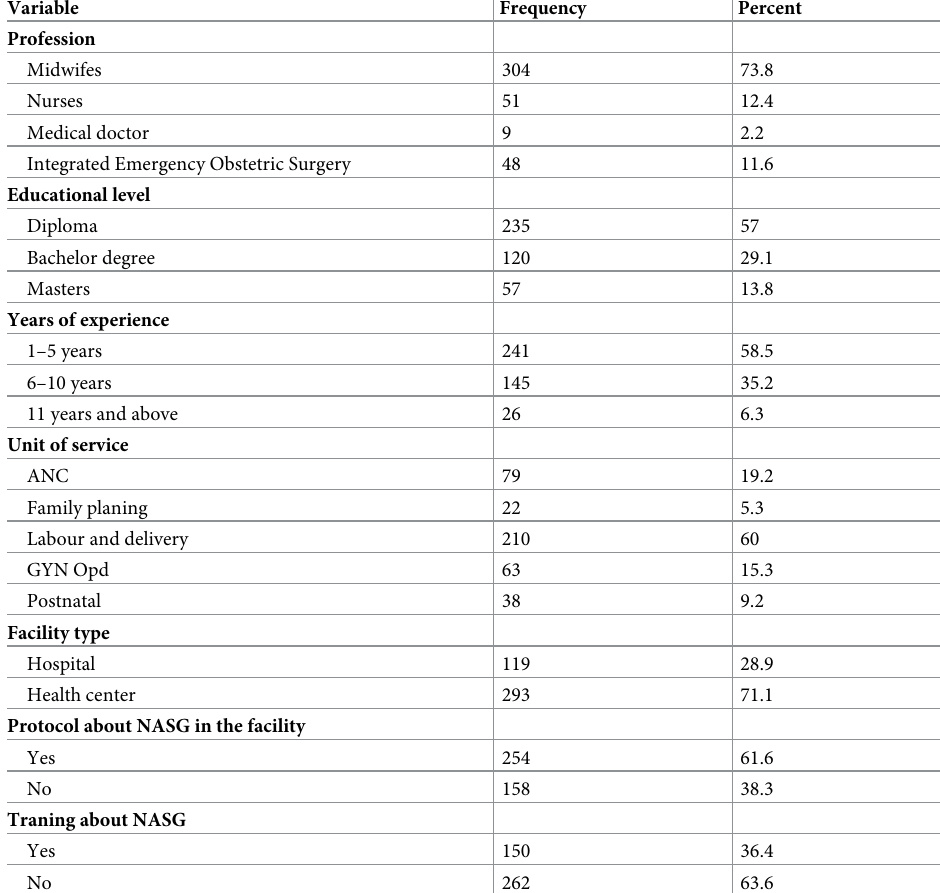
Table 2. Provider and facility-related factors of the obstetric care providers in public health facilities of Southern Ethiopia,